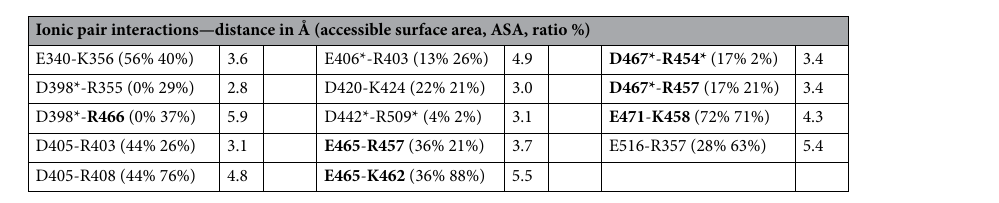
Table 2. Electrostatic pair interactions between negatively and positively charged residues. The N–O distance between basic and acidic groups is shown at the right of each pair. The outlined residues correspond to the RBM region, and the other ones to the core. The values in brackets correspond to the accessibility of the interacting residues, expressed as the percentage of surface exposed. Occluded charged residues (ASA ratio < 20%) are marked with an asterisk. The index of each residue corresponds to the numbering in the Spike protein. For this analysis we used the structure of chain E of the pdb code 6m0j 19 .